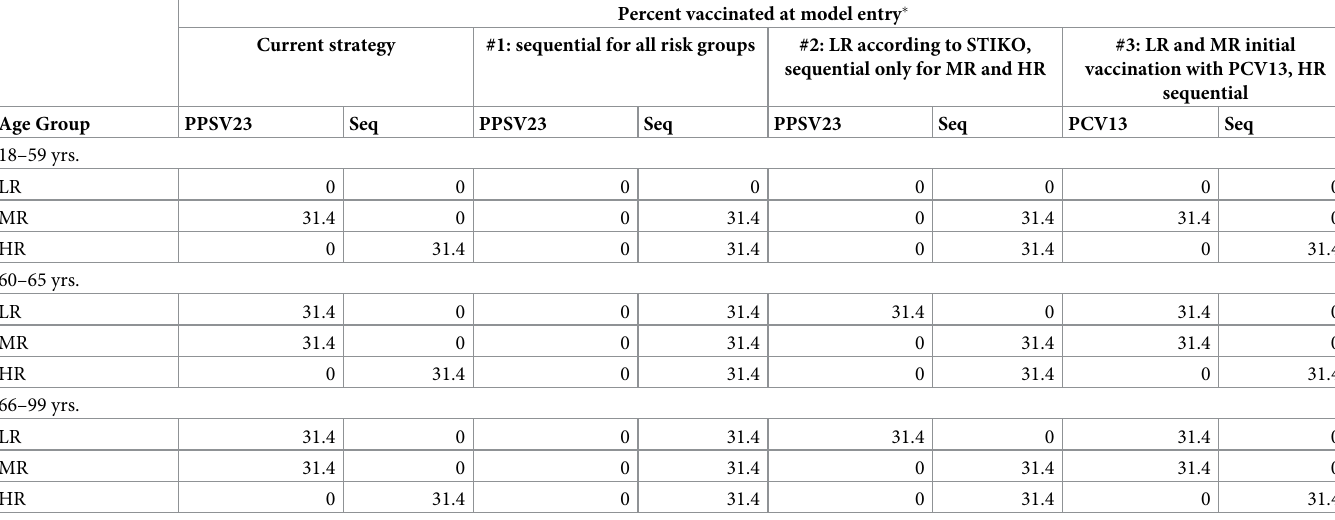
Table 6. Overview of current STIKO recommendation and hypothetical strategies (#1